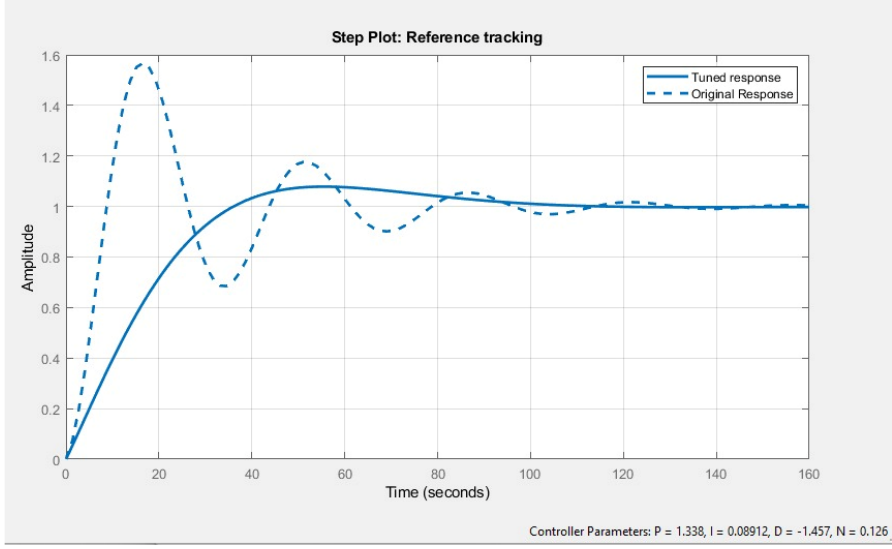
Figure 17. Time response of vapor compression cycle before tuning and after tuning.